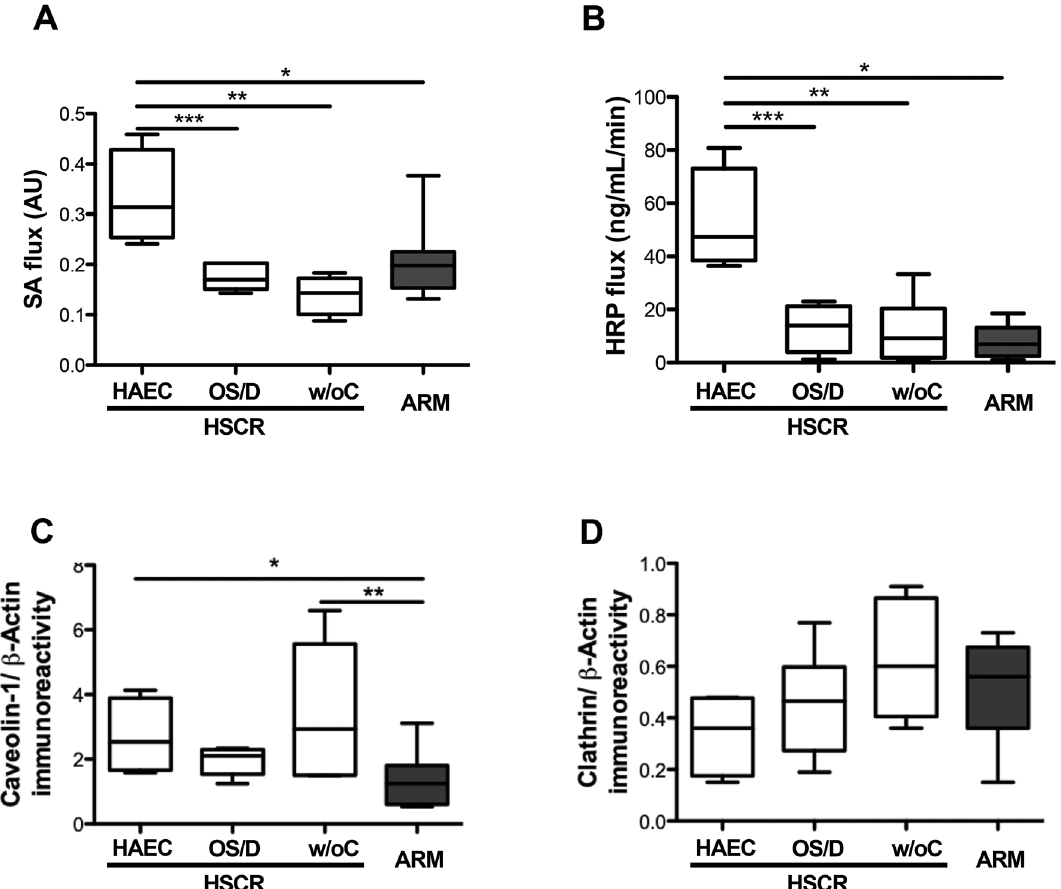
without complications (w/oC)) and in ARM (grey bar) patients. ( A ) Paracellular permeability measured with sulfonic acid (SA) flux (* p = 0.02; ** p = 0.0095; *** p = 0.016), and ( B ) transcellular permeability measured with and Horse Radish Peroxydase (HRP) flux (* p = 0.013; ** p = 0.017; *** p = 0.029). Mucosal expression of ( C ) caveolin-1 (* p = 0.03; ** p = 0.04) and ( D ) clathrin in Western Blot. Medians with ranges. AU: arbitrary